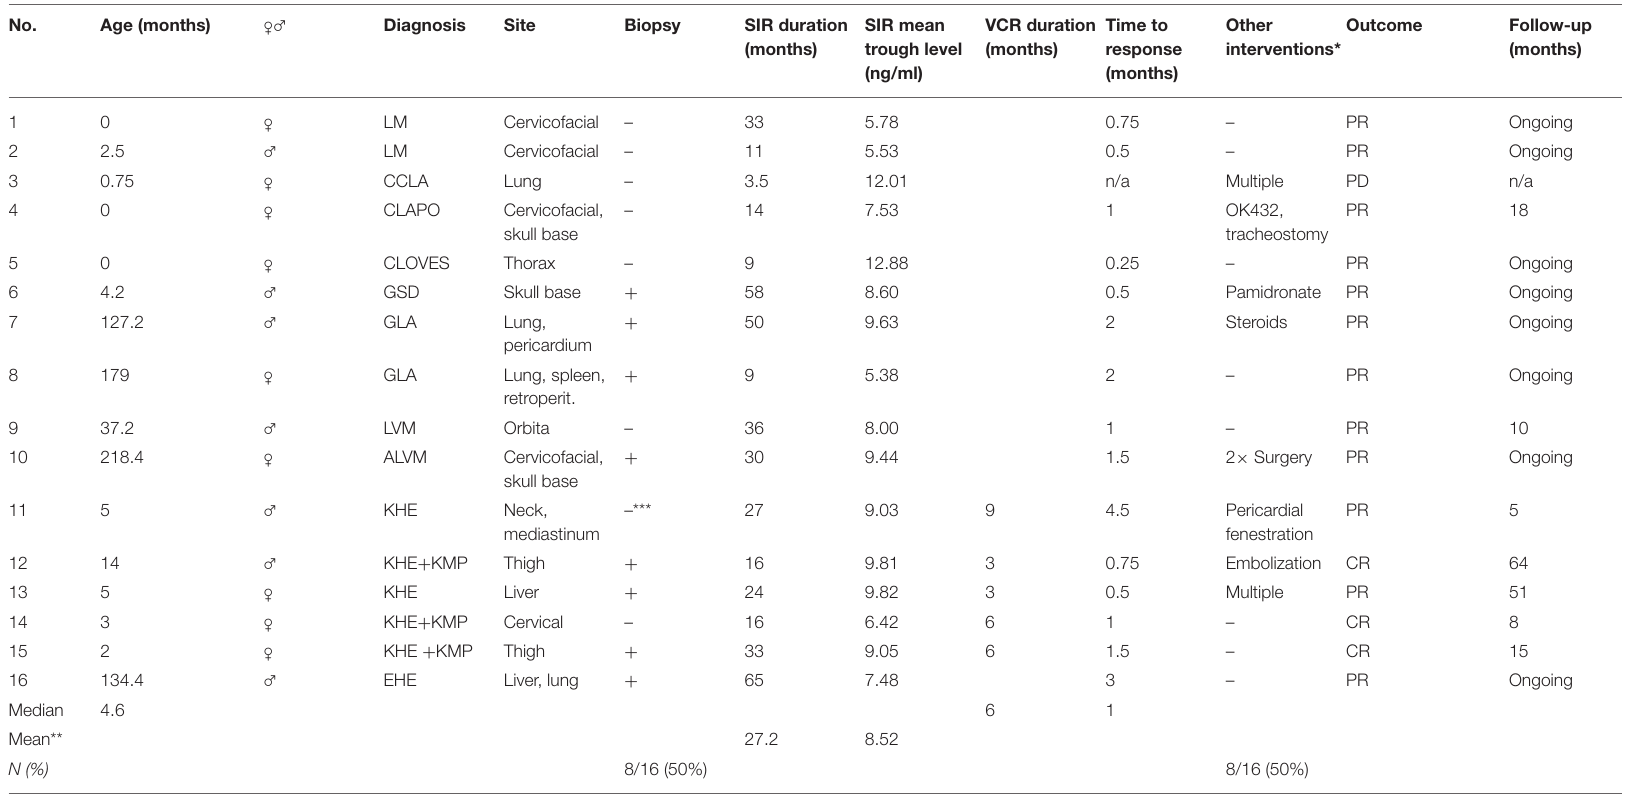
TABLE 1 | Patient characteristics and clinical course.